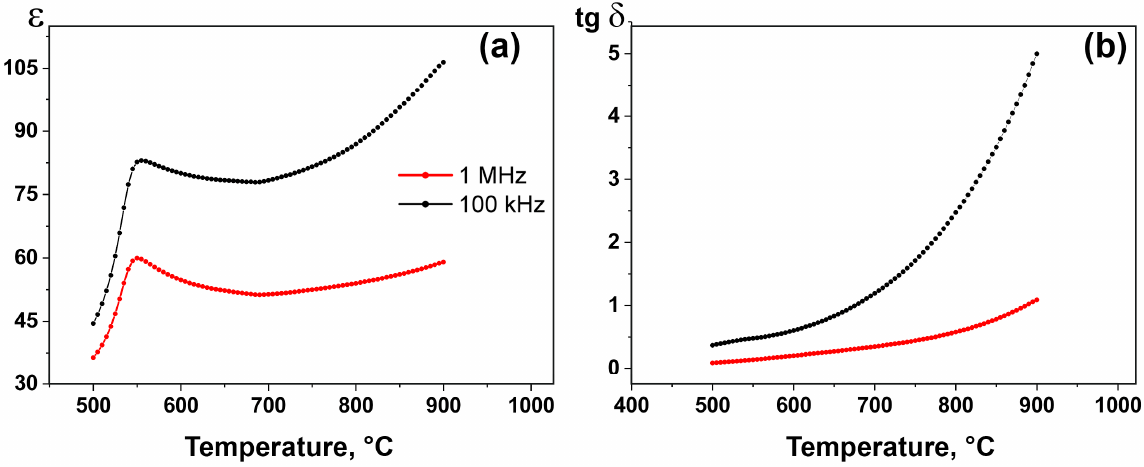
Figure 3. The temperature dependence of the dielectric permittivity ε (T) ( a ) and the dielectric loss tangent (tg δ ) ( b ) for Ca 8 MnEu(PO 4 ) 7 at 50 kHz and 1 MHz (on heating).